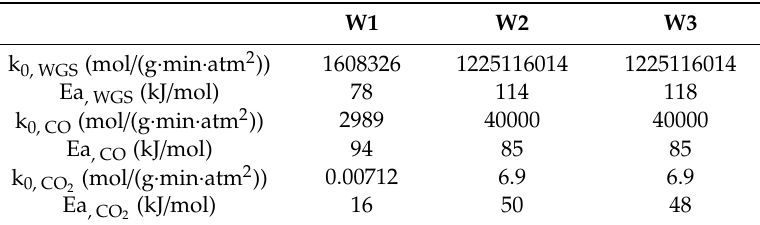
Table 2. Kinetic parameters for the powder